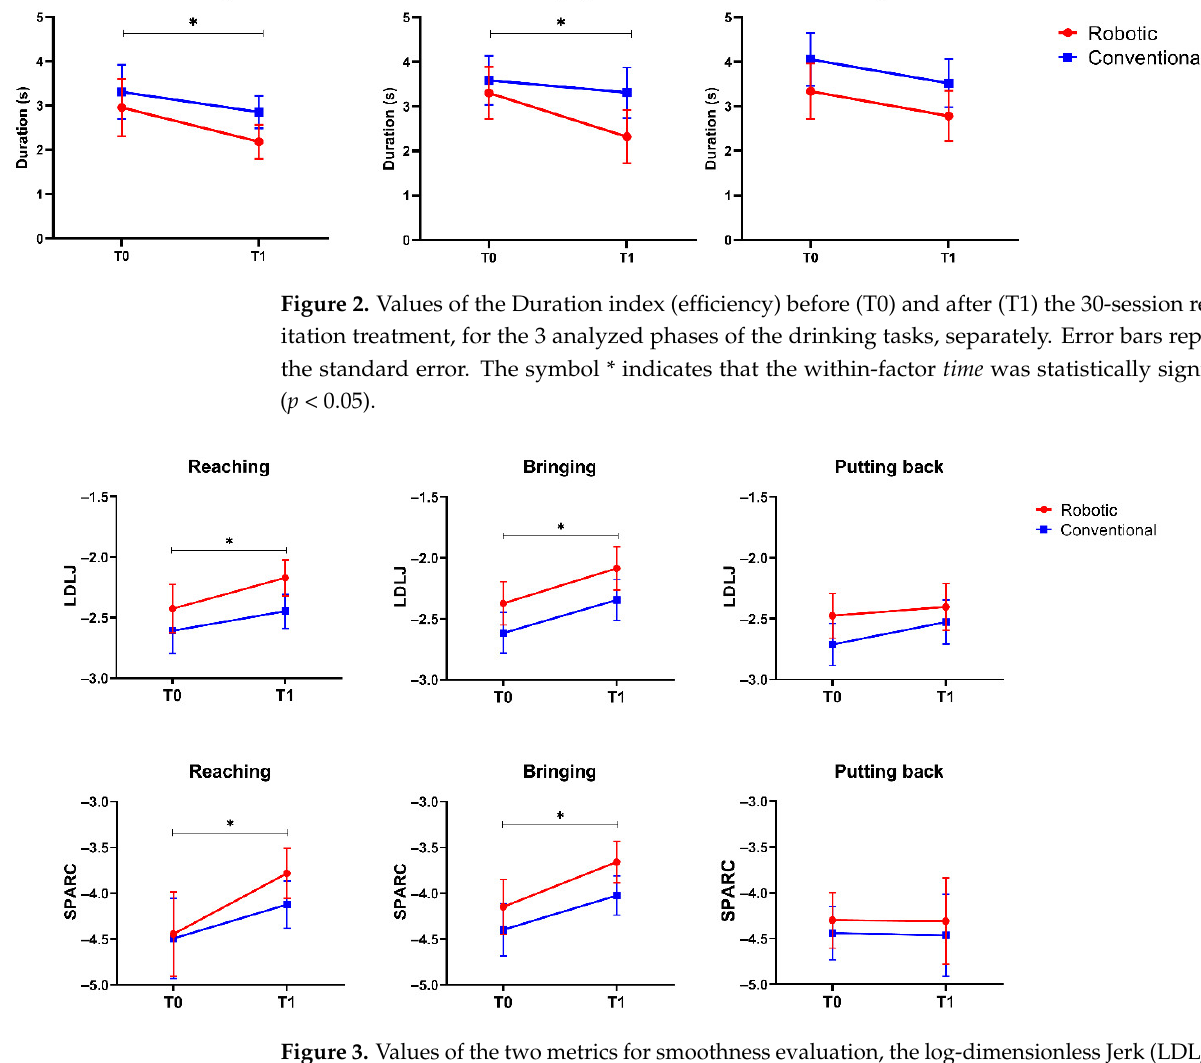
Figure 3. Values of the two metrics for smoothness evaluation, the log-dimensionless Jerk (LDLJ), and the Spectral Arc Length (SPARC), before (T0) and after (T1) the 30-session rehabilitation treatment, for the 3 analyzed phases of the drinking tasks, separately. Error bars represent the standard error. The symbol * indicates that the within-factor time was statistically significant ( p < 0.05). Table 4. Quantitative indices related to the investigated drinking task, for the two groups and the three phases, separately. p -values lower than 0.05 are highlighted in bold.